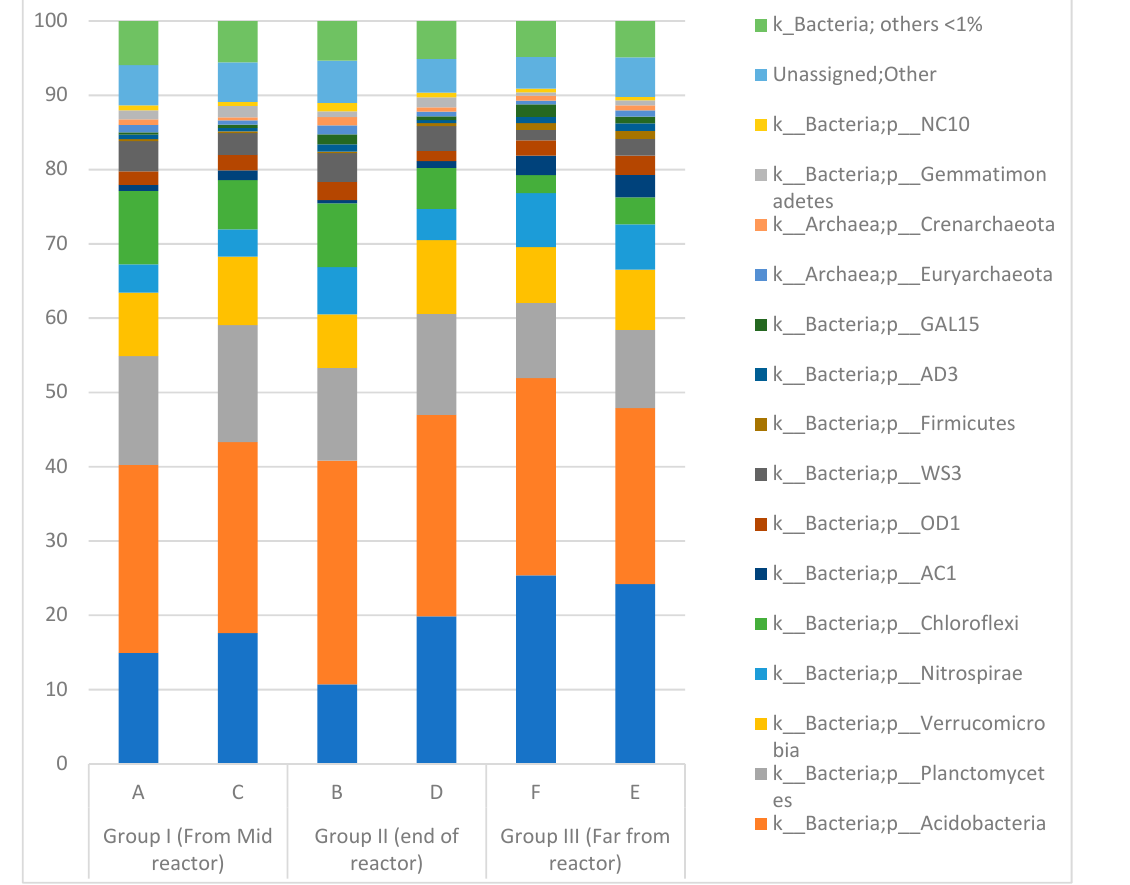
Figure 8. Microbial communities in the paddy field soil with relative abundance >1%.